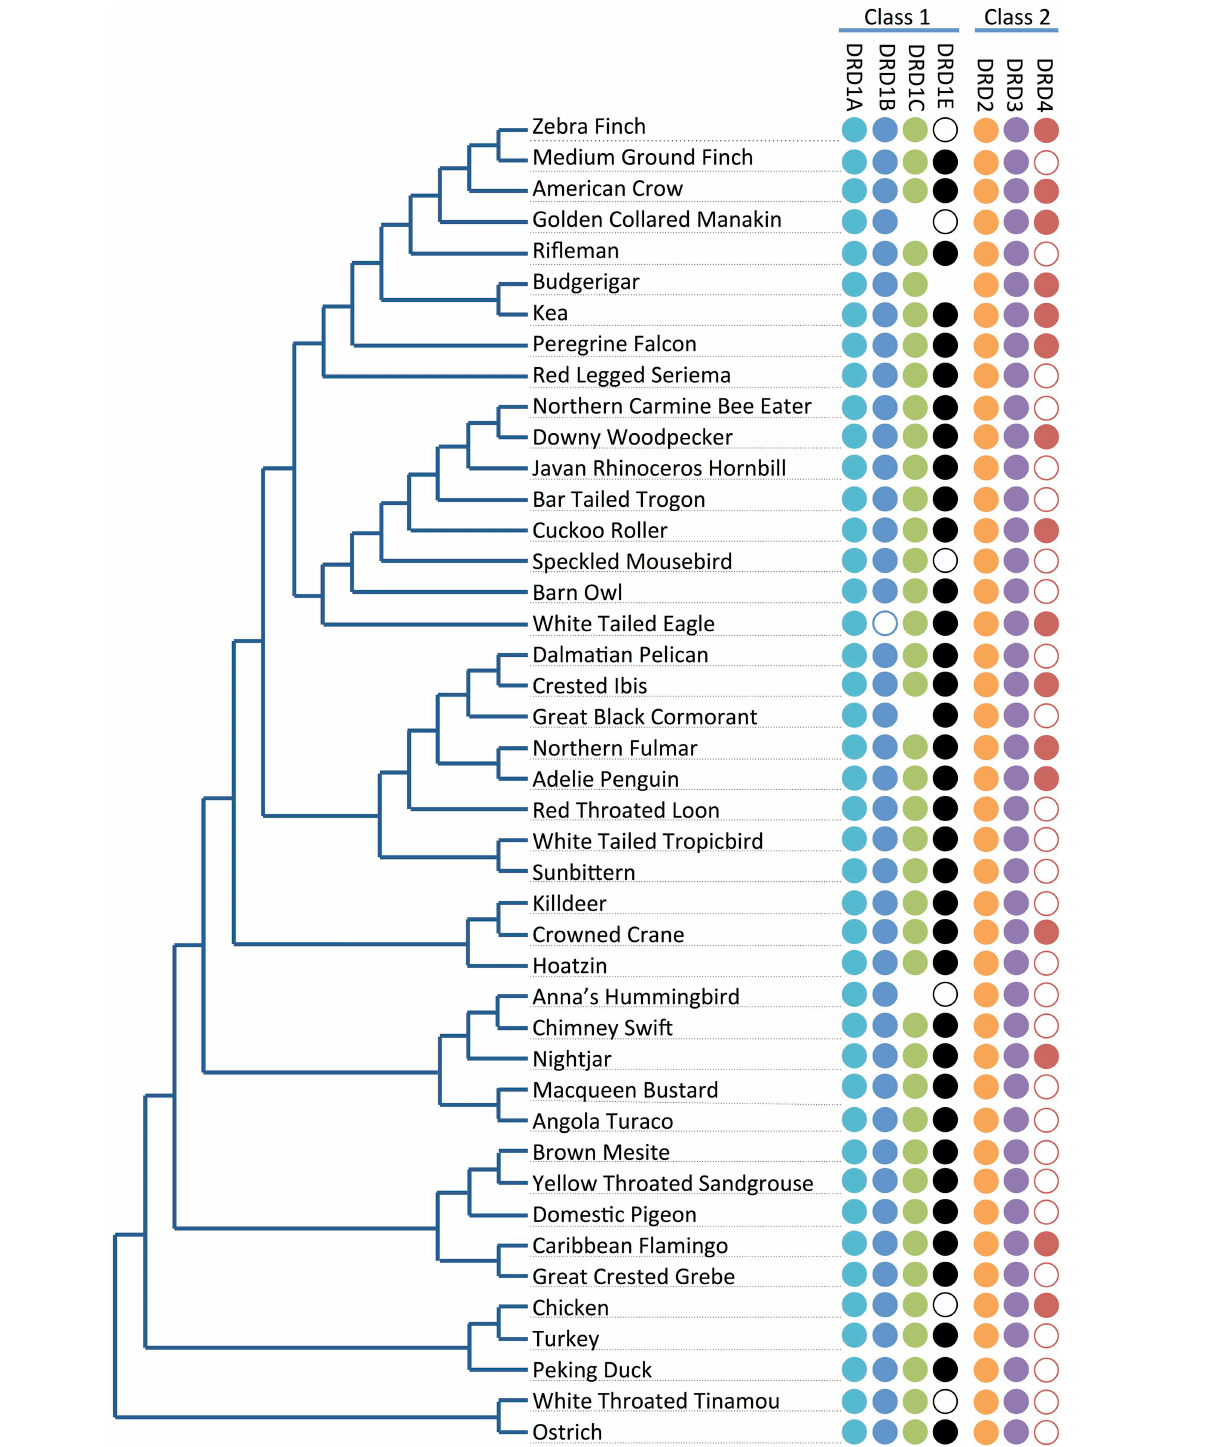
Frontiers in Neuroscience |